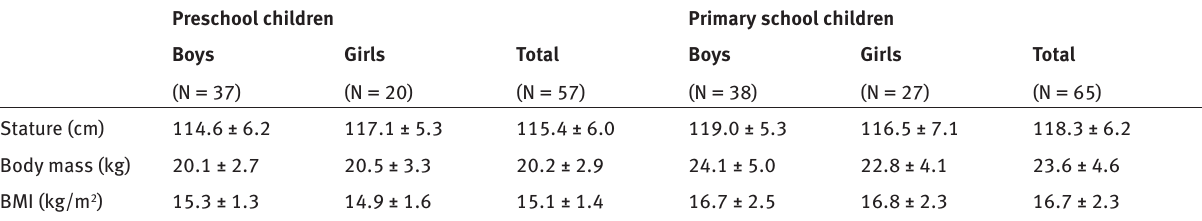
Table 1 : Detailed characteristics of the participants. Values are presented as mean ± SD. Preschool